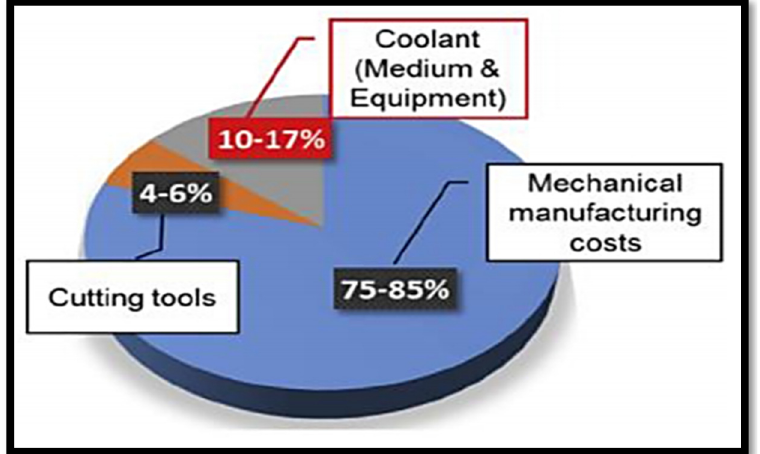
Figure 11. The quantitative distribution of manufacturing costs in industries [94].